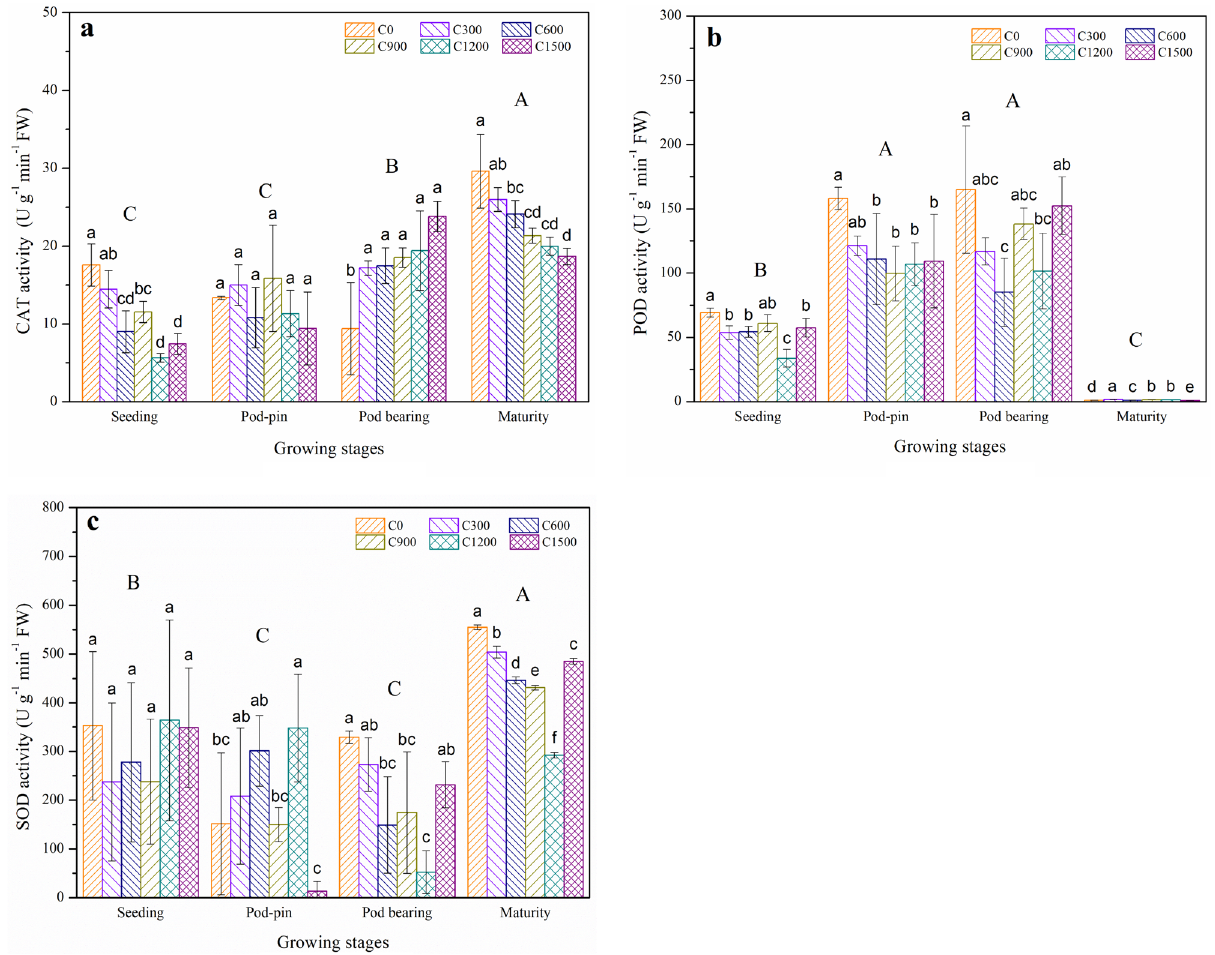
Figure 4. Effects of slaked lime application on the contents of ( a ) catalase (CAT), ( b ) peroxidase (POD) and ( c ) superoxide dismutase (SOD) in peanut leaves. The values are means (± SD) of three replicates. Bar groups with different capital letters indicate significant differences ( p < 0.05) among the growth stages. Bars with different lowercase letters indicate significant differences ( p < 0.05) among the six slaked lime treatments for the same growth